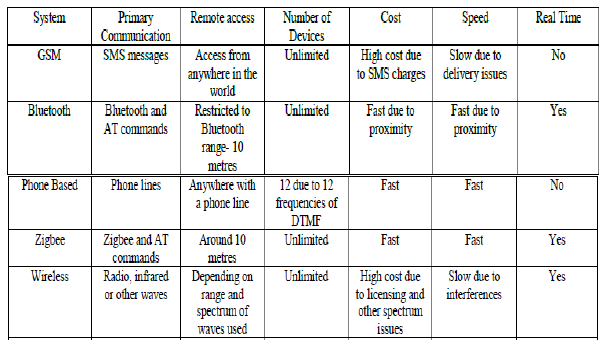
Fig.1. Comparison of energy cost, speed for Phone based and